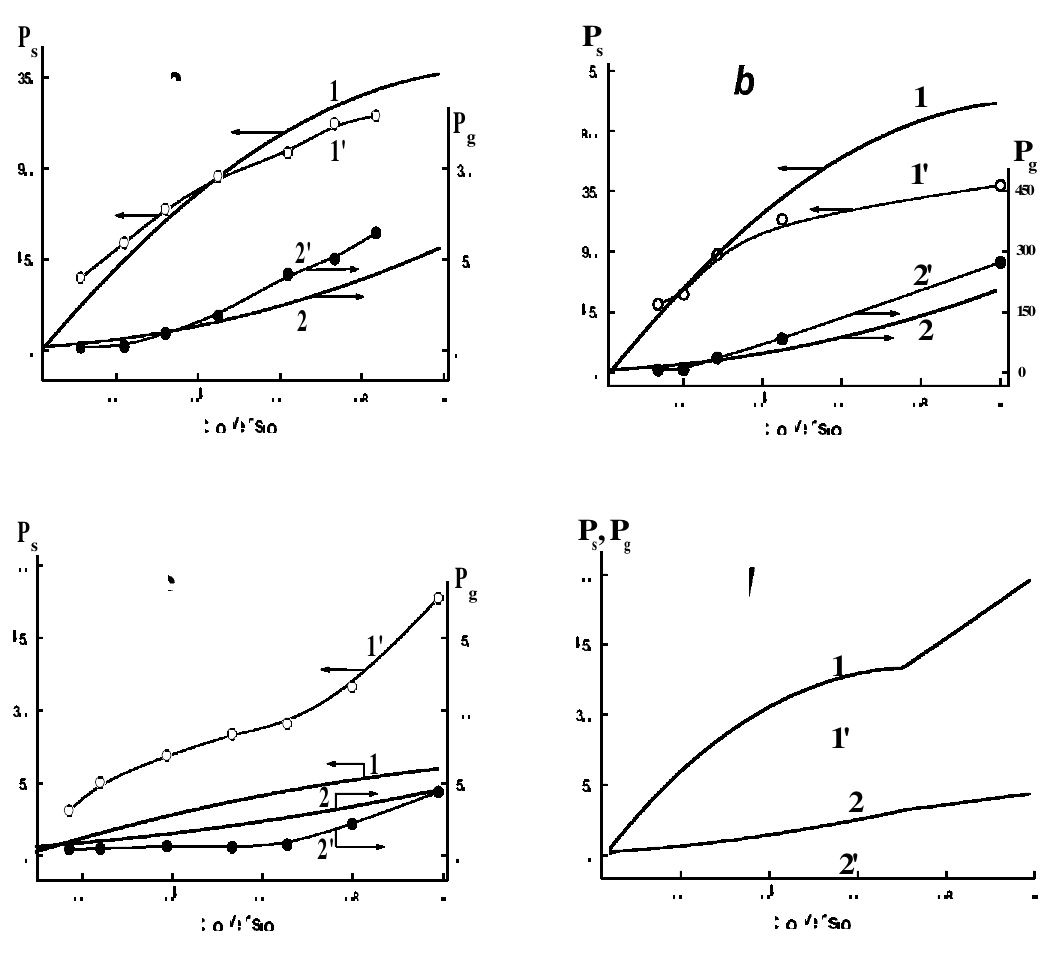
Fig. 7 Experimental and calculated dependencies of P of the reagents see in the Table 1; 1 and 2 { the calculated curves, 1’ and 2’ { the experimental